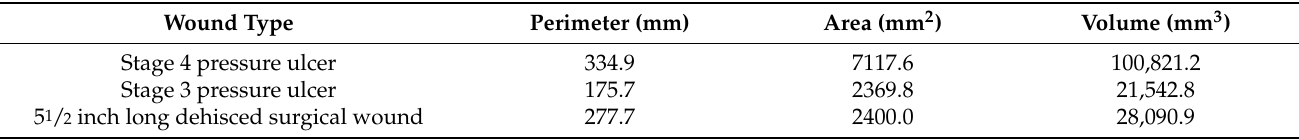
Table 1. Ground truth for the measurements of Seymour II wound care